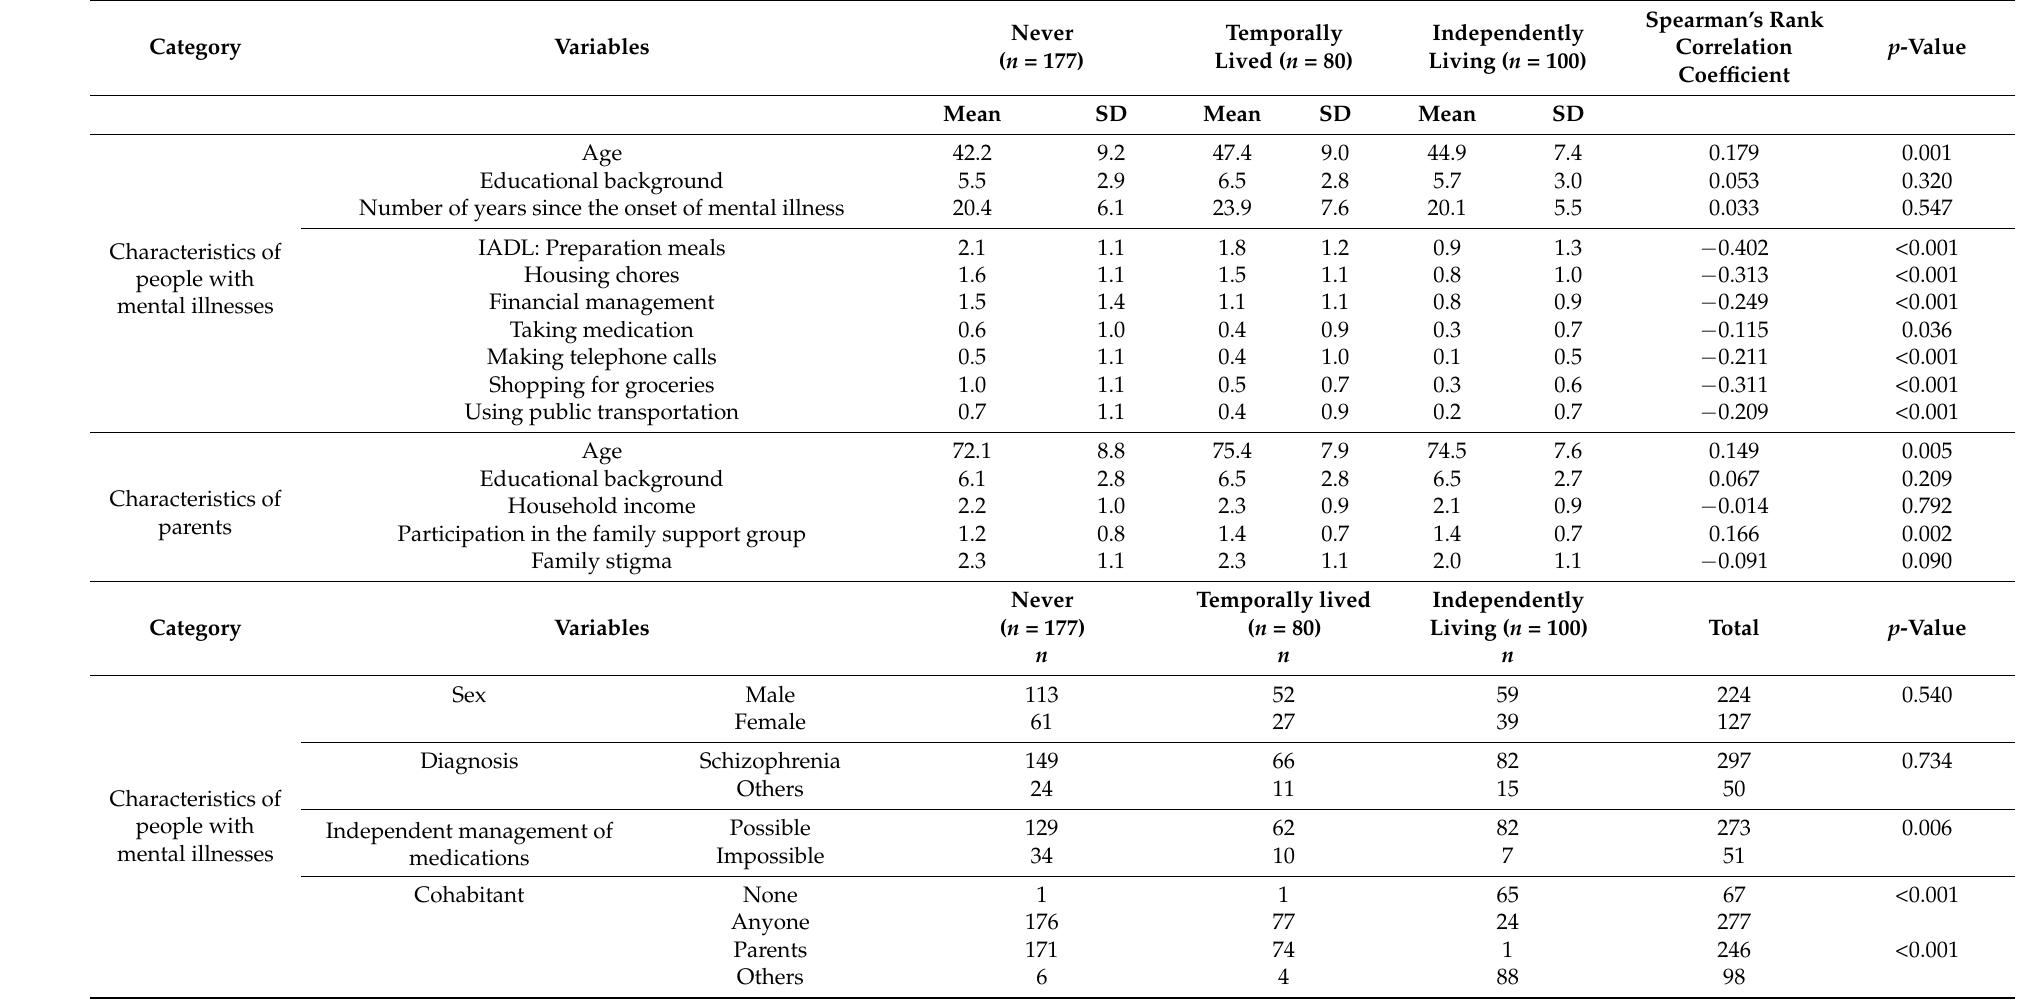
Table 1. Characteristics of people with mental illnesses and their parents ( N =